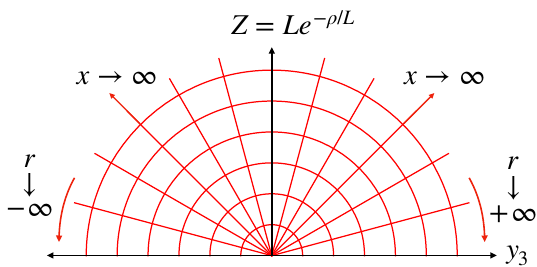
Figure 6. Coordinates for Janus configurations, with ( t, y 1 , y 2 ) suppressed. We have ρ ∈ ( −∞ , + ∞ ) and y 3 ∈ ( −∞ , ∞ ) , with the conformal boundary located at ρ → ∞ ,